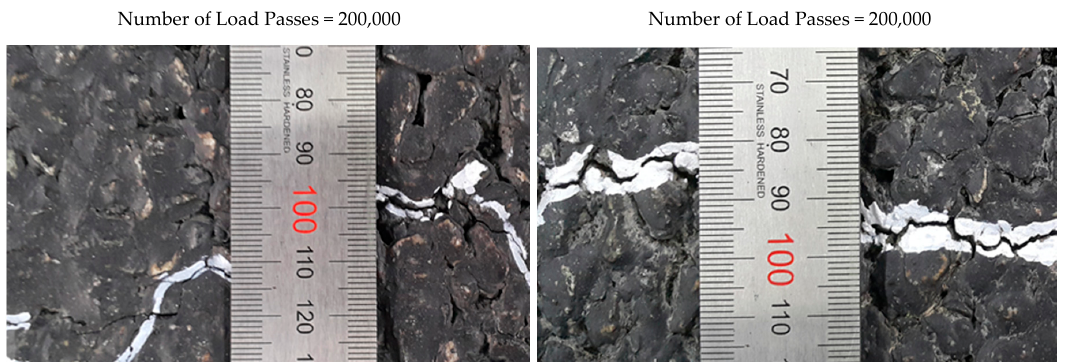
Figure 11. Occurrence and progression of reflective cracks.